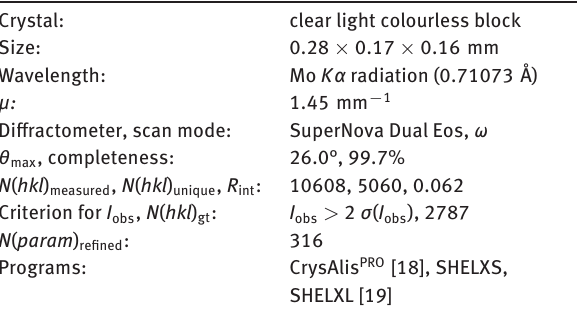
Table 1: Data collection and